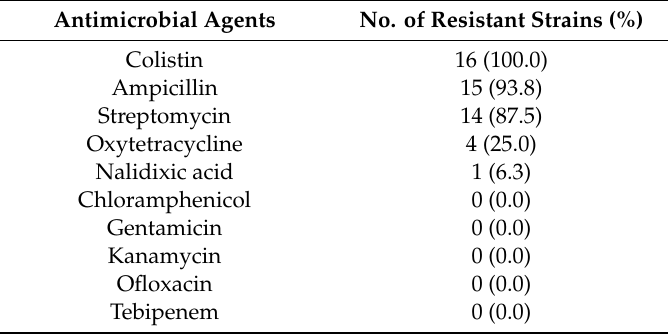
Table 3. Antimicrobial resistances of Vp AHPND strains ( n =